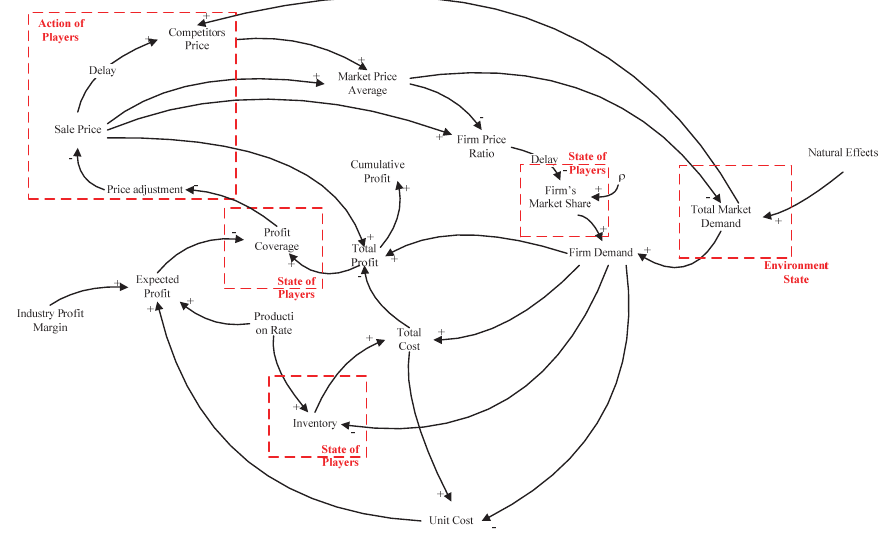
Fig. 5. The proposed cause and effect relationships in oligopoly market